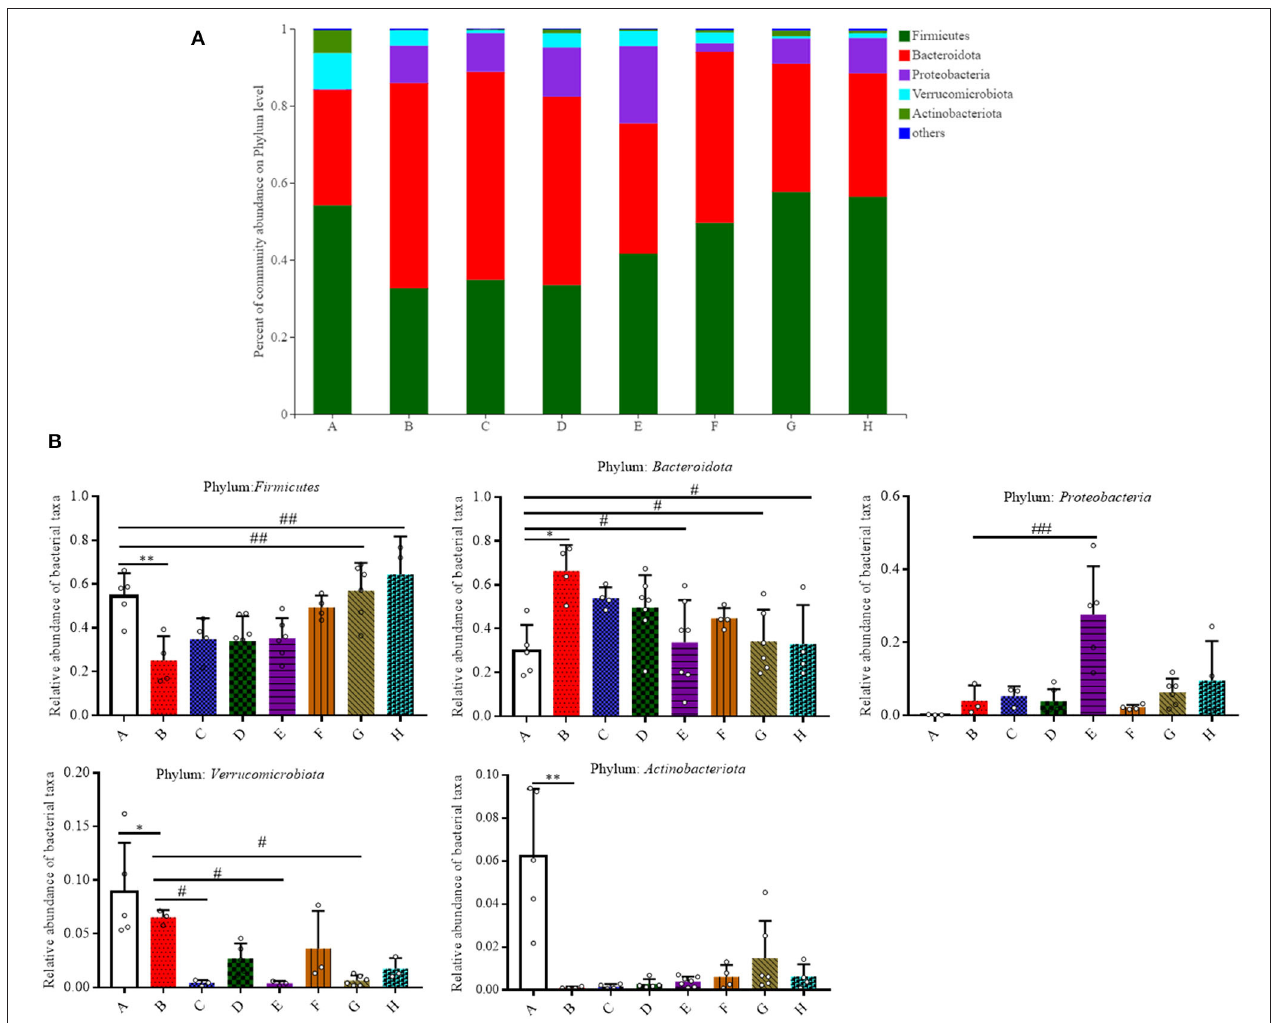
FIGURE 3 | Effect of SFN on gut microbiota compositions at the phylum level in colitis mice. (A) Gut microbiota compositions at the phylum level in each group. (B) Relative abundance of predominant bacterial community members at the phylum level. All data are presented as the mean ± SD. P -value < 0.05 was considered to indicate statistical significance (* P < 0.05 and ** P < 0.01 compared with Group A, # P < 0.05 and ## P < 0.01 compared with Group B).